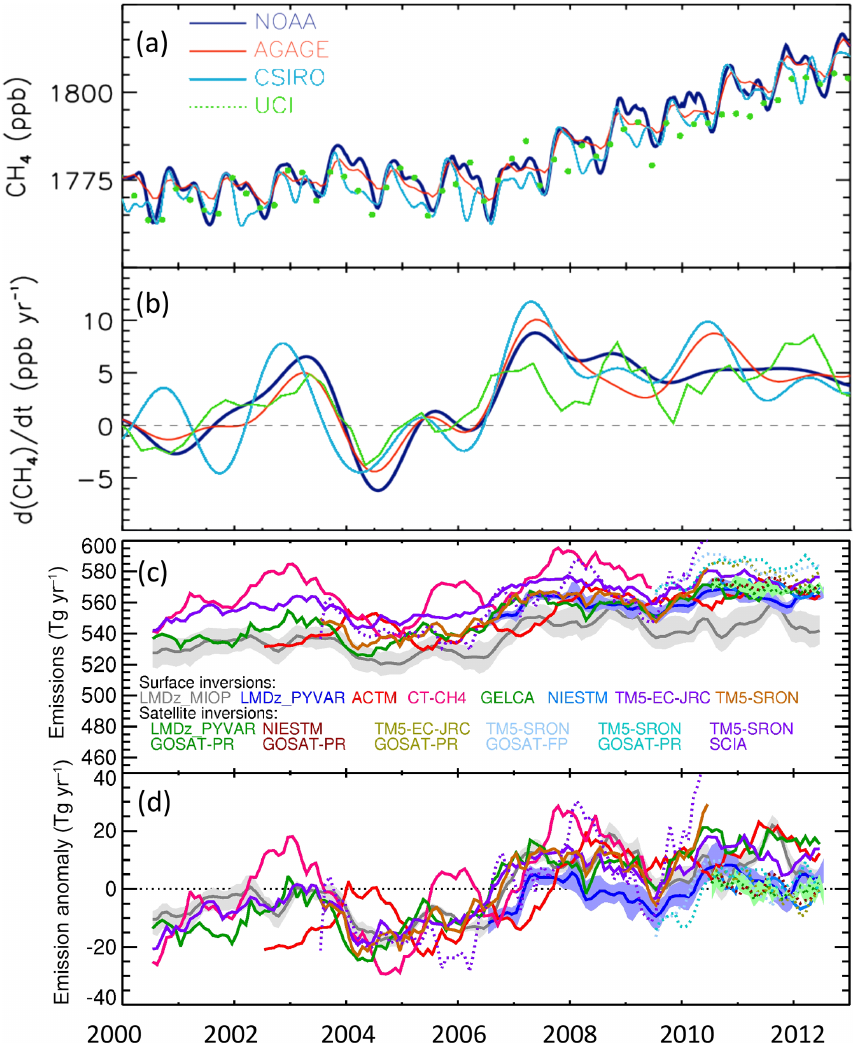
Figure 1. Evolution of the global methane cycle since 2000. (a) Observed atmospheric mixing ratios (ppb) as synthesised for four different surface networks with a global coverage (NOAA, AGAGE, CSIRO, UCI). (b) Global growth rate computed from (a) in ppbyr − 1 . The 12- month running mean of (c) the annual global emission (Tg CH 4 yr − 1 ) and (d) the annual global emission anomaly (Tg ‘CH 4 yr − 1 ) inferred by the ensemble of